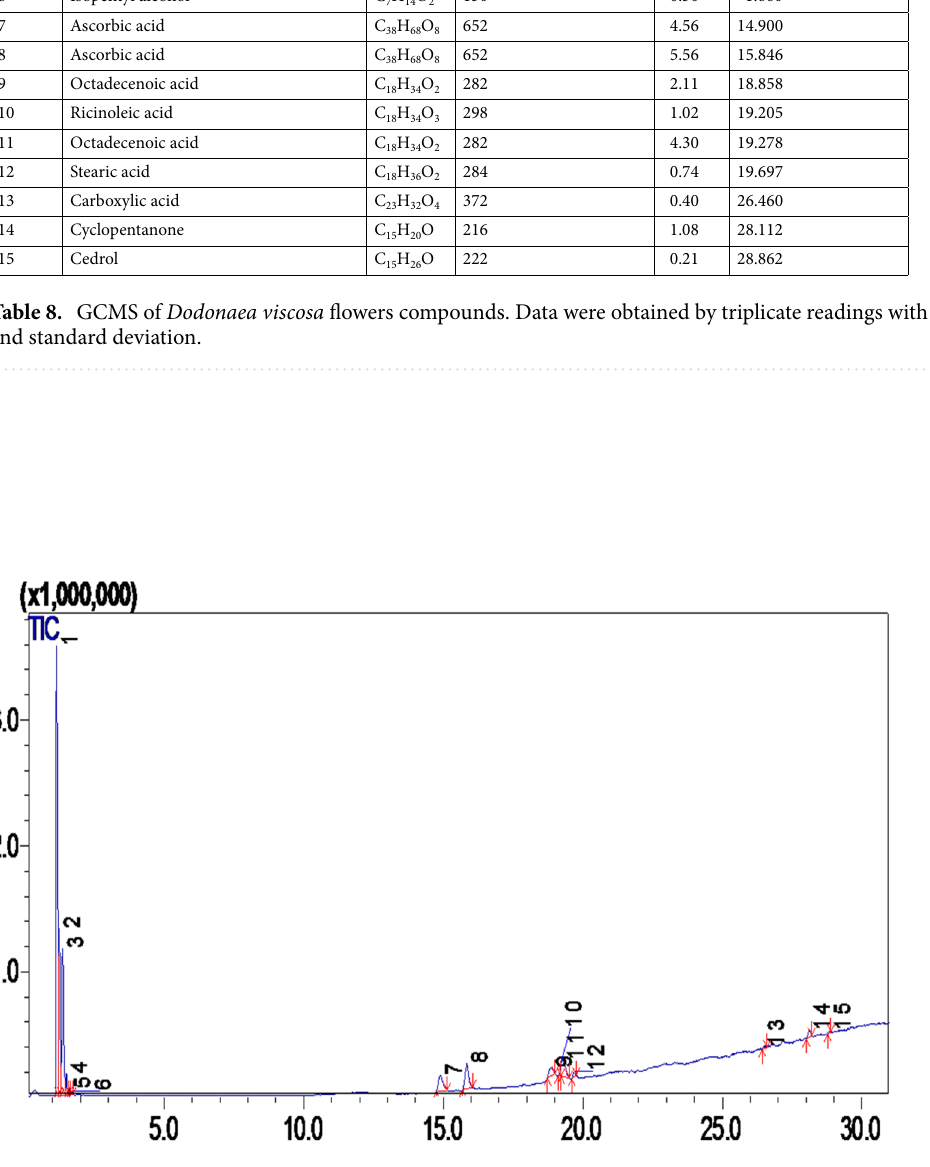
Figure 3. GCMS Chromatogram of Dodonaea viscosa